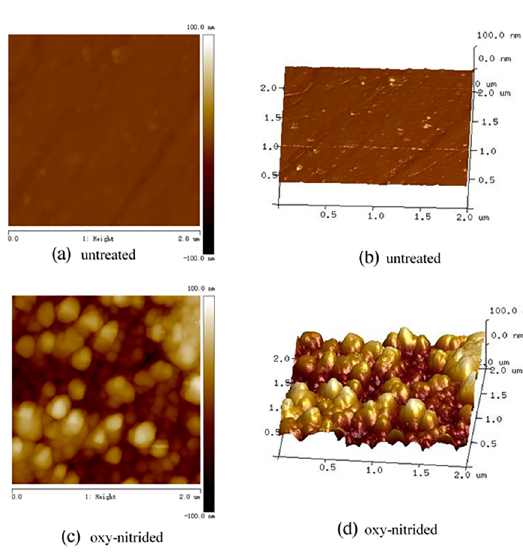
Figure 5 . AFM images of untreated (a, b) and the 440°C oxy- nitrided (c, d) samples.